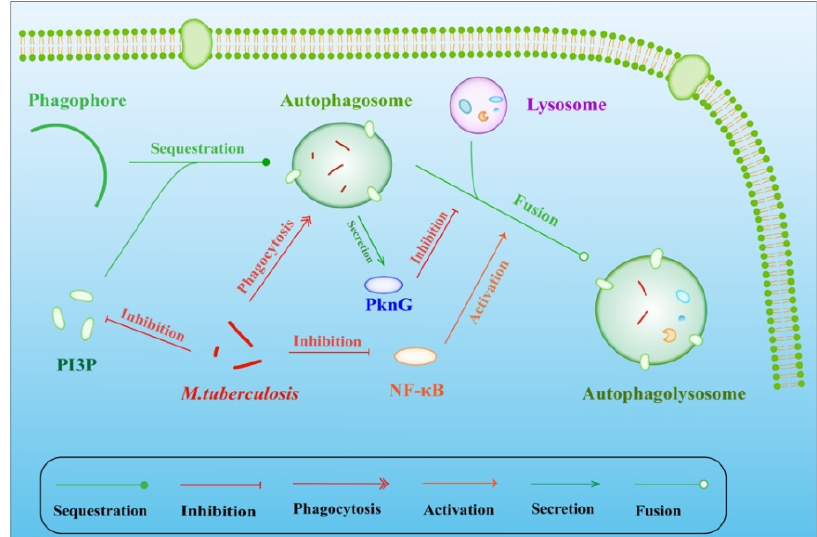
Figure 1. MTB evasion by inhibiting fusion of lysosomes with phagosomes. While the secretion of PknG by phagocytic MTB directly inhibits the fusion of phagosomes with lysosomes, the suppression of NF- κB also decreases this fusion. As an important component on the phagosome surface, lower biosynthesis and higher hydrolysis of PI3P also suppresses the fusion, providing an escape channel for MTB.